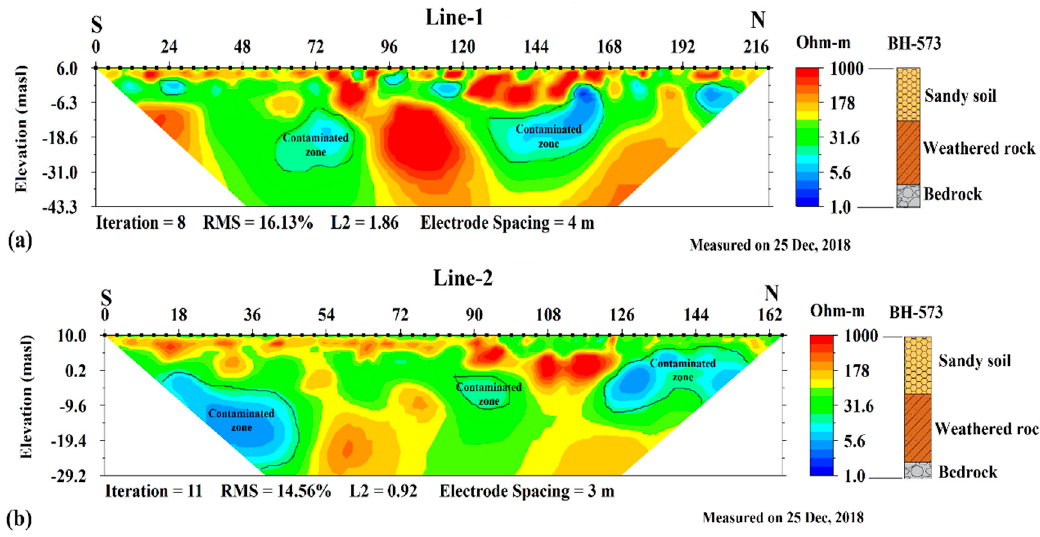
Figure 6. Two-dimensional (2D) ERI result: ( a ) Line-1 and ( b ) Line-2.